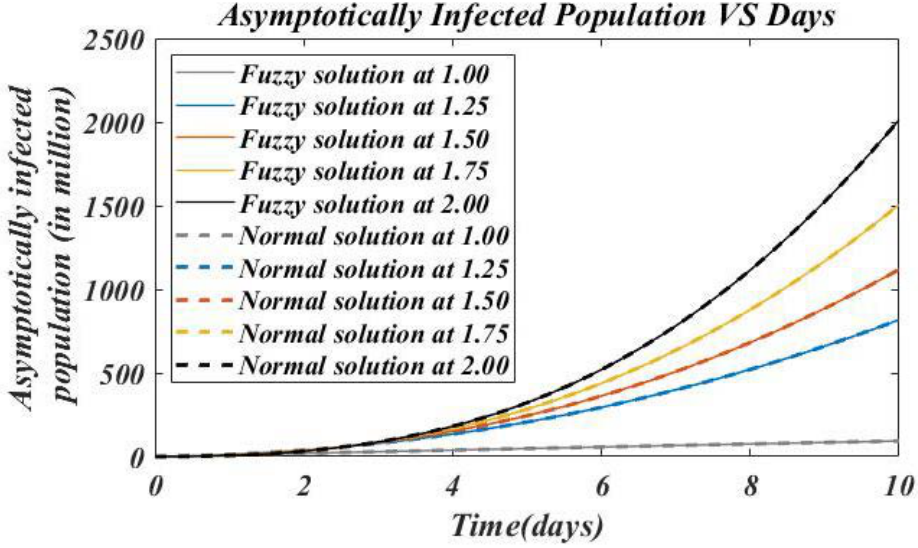
Figure 8. Illustration of approximate fuzzy and normal asymptotically infected compartment solu- tions for five terms at given uncertainty levels ϑ ∈ [ 1,2 ] versus fractional